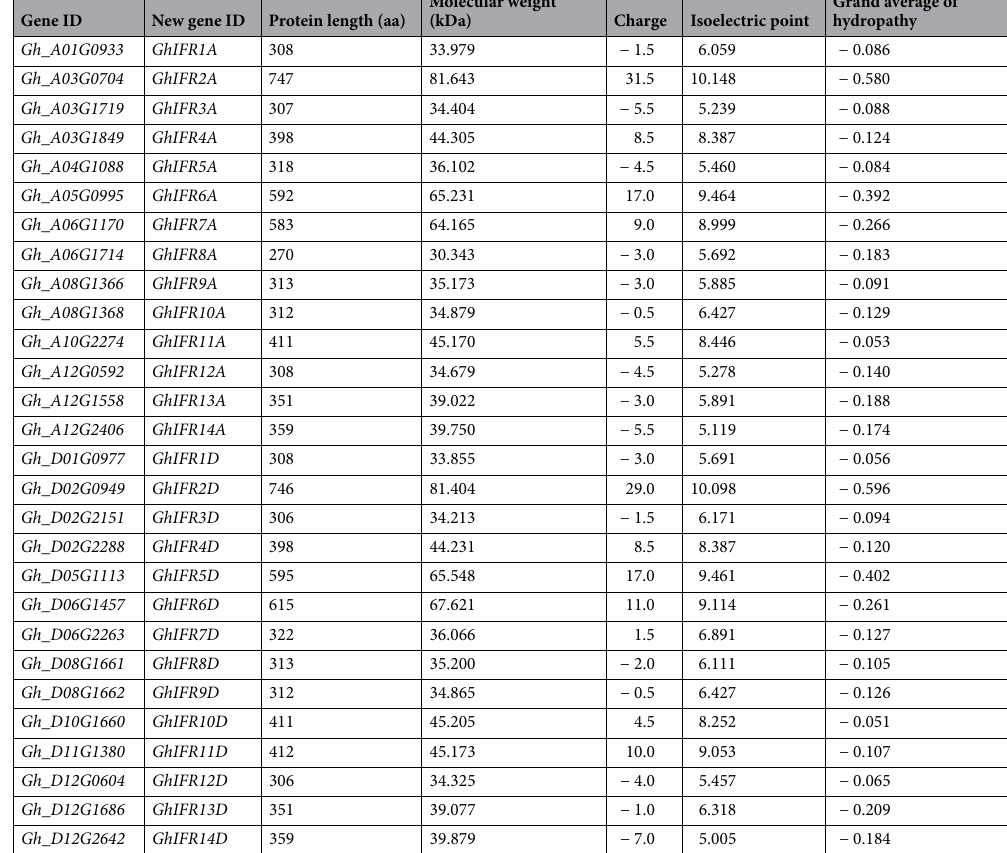
Table 1. Physical properties of the GhIFR